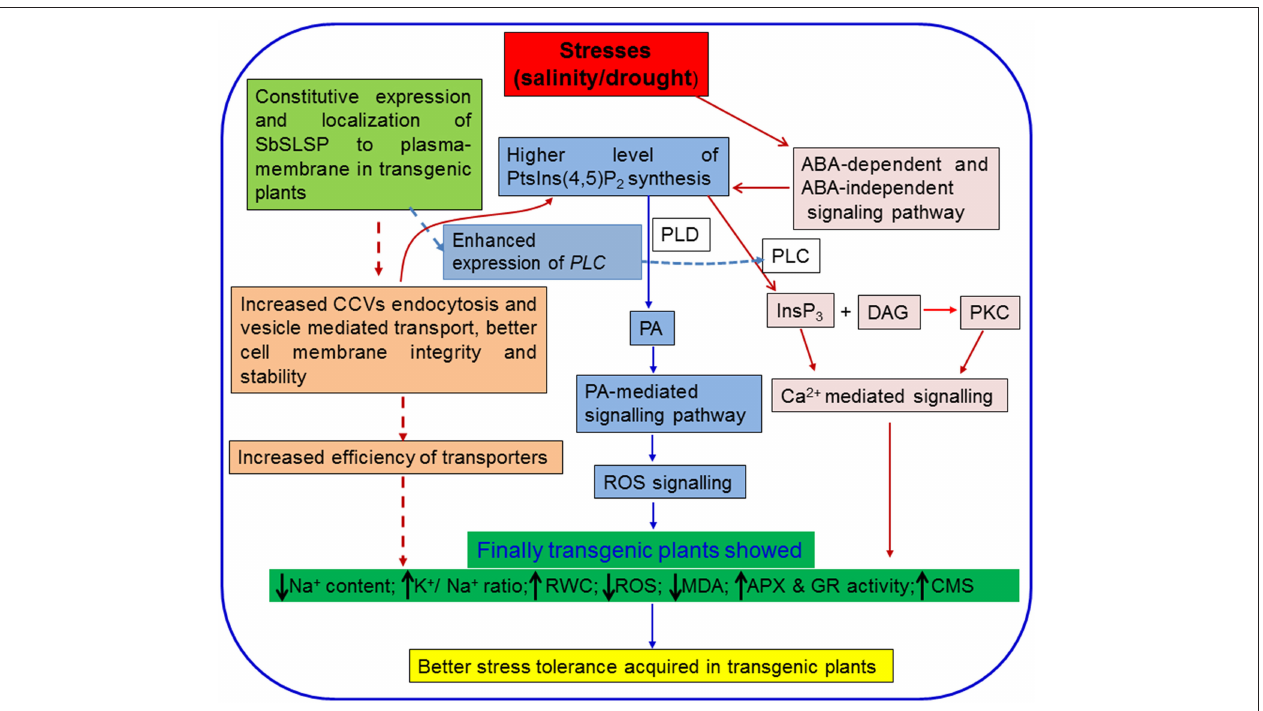
FIGURE 8 | A hypothetical model for the role of SbSLSP in abiotic stress tolerance. The model represents the established signaling cascade under abiotic stresses. The hypothesized plausible role of SbSLSP in stress tolerance was represented by broken lines. Constitutive overexpression of SbSLSP protein may leads to increased clathrin coated vesicles mediated endocytosis leading to higher accumulation of PtsIns(4,5)P 2 and then PA mediated stress signaling, which increased the efficiency of transporters and cell membrane stability. The SbSLSP somehow increased the transcript expression of PLC gene which may contribute to the increased Ca 2 + mediated signaling pathway. Conclusively all these pathways converge together and results in better abiotic stress tolerance in the transgenic plants. CCVs: Clathrin coated vesicles; PtsIns(4,5) P 2 : phosphatidyl-inositol-4,5-bisphosphate; PLC: phospholipase C; PLD: phospholipase D; PA: phosphatidic acid; InsP 3 : inositol-1,4,5-triphosphate; DAG: diacylglycerol; PKC: protein kinase